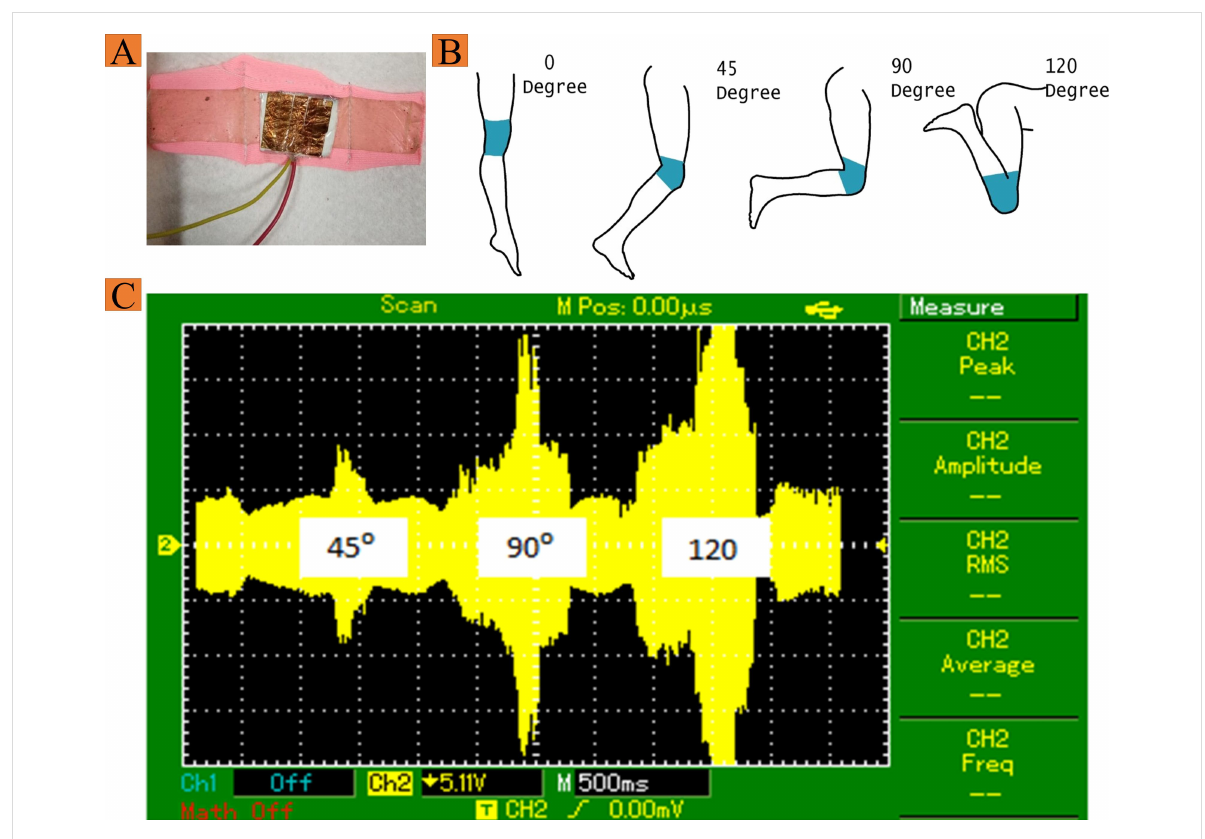
Figure 5: Integration of nanofibrous mesh into a knitted fabric for human body angle measurement (A), schematics showing the dressed knee at dif- ferent bending angles (B), and digital oscilloscope graph at the corresponding angles (C).